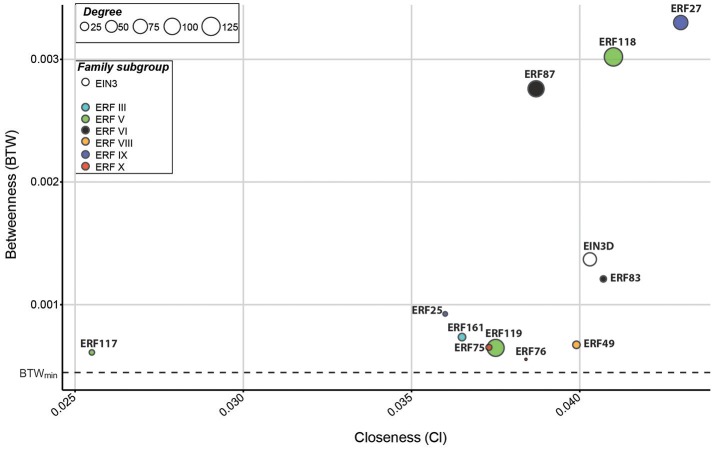
EIN3D and ERFs function as hubs in the wood transcriptome. The graph shows betweenness (BTW) and closeness (Cl) values of EIN3 and ERFs expressed in AspWood (defined in Sundell et al., 2017). Circle size corresponds to their degree. All genes with expression profiles in AspWood were ranked according to their BTW, and the top 20% genes (n, 2,777) were defined as hub genes (listed in Supplementary Table S4). Dotted lines mark the minimum BTW value (0.000447) calculated for a hub gene.